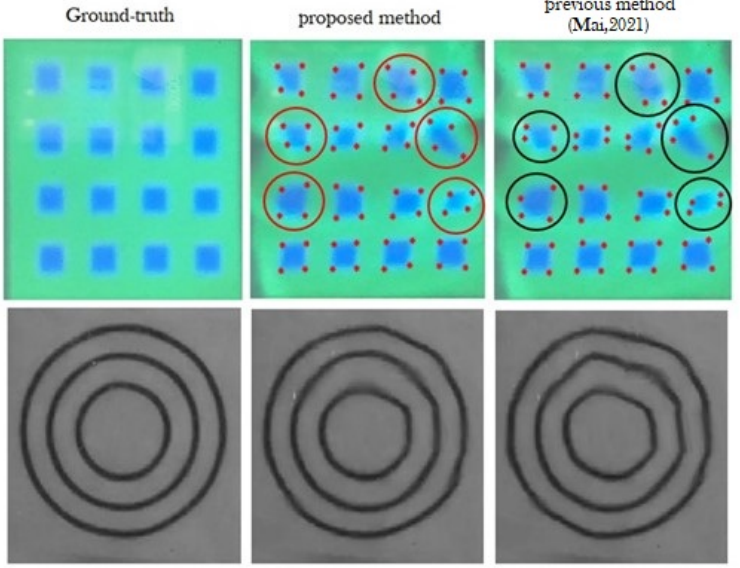
Figure 15. An example of recovery results using the different corner-detection algorithms [58].